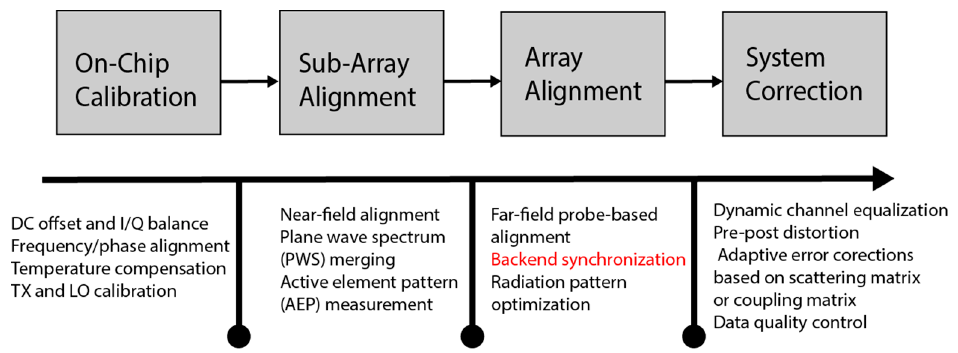
Figure 6. General system calibration procedure for digital array radar and the focus of this work (in